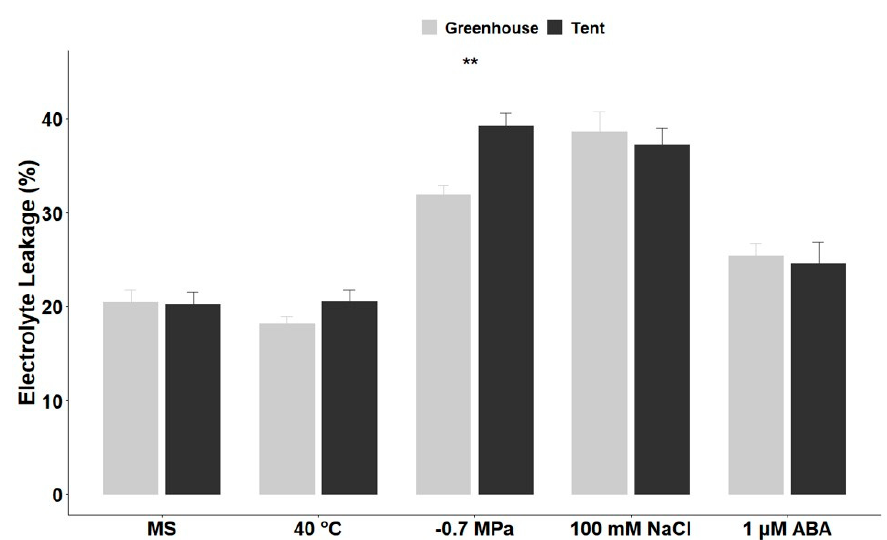
Figure 6. Electrolyte leakage percentage in petunia seedlings after treatment with high temperature, dehydration, NaCl, and ABA. Electrolyte leakage was measured after 10 days of treatment. Five replications with 4 seedlings for each replication ( n = 20 total) from greenhouse or tent plants were applied to each treatment. The vertical bars represent the mean ± standard error. ** Significant difference between seedlings from seeds originating from plants grown in the greenhouse and the tent under the same treatment condition at p < 0.01 ( t -test).